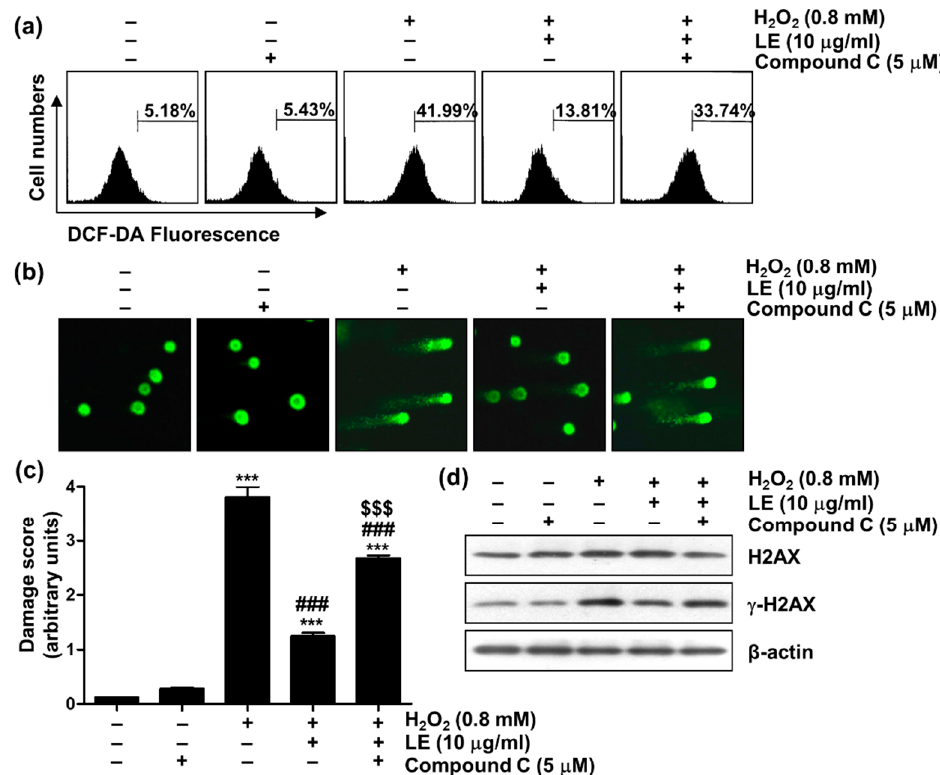
Figure 6. AMPK-dependent effect of LE on H 2 O 2 -induced ROS generation and DNA damage in C2C12 cells. Cells were pretreated using 5 µ M compound C, with or without 10 µ g/mL LE, for 1 h, followed by 0.8 mM H 2 O 2 for 1 h ( a ) or 24 h ( b – d ). ( a ) After staining with DCF-DA, DCF fluorescence was measured using flow cytometry. Representative results of three independent experiments are shown; ( b ) DNA damage was measured using the comet assay. DNA damage is observed in the comet’s tail, while intact DNA remains in the comet’s head. Representative results of three independent experiments are shown; ( c ) DNA damage score. Data indicate mean ± SD values ( n = 3; *** p < 0.001 vs. control cells; ### p < 0.001 vs. H 2 O 2 -treated cells; $$$ p < 0.001 vs. H 2 O 2 and LE treated cells); ( d ) Cellular proteins were prepared and H2AX and γ -H2AX protein levels were analyzed. Western blot analysis was performed using β -actin as a loading control. Representative results of three independent experiments are shown. H2AX, H2A histone family member X.